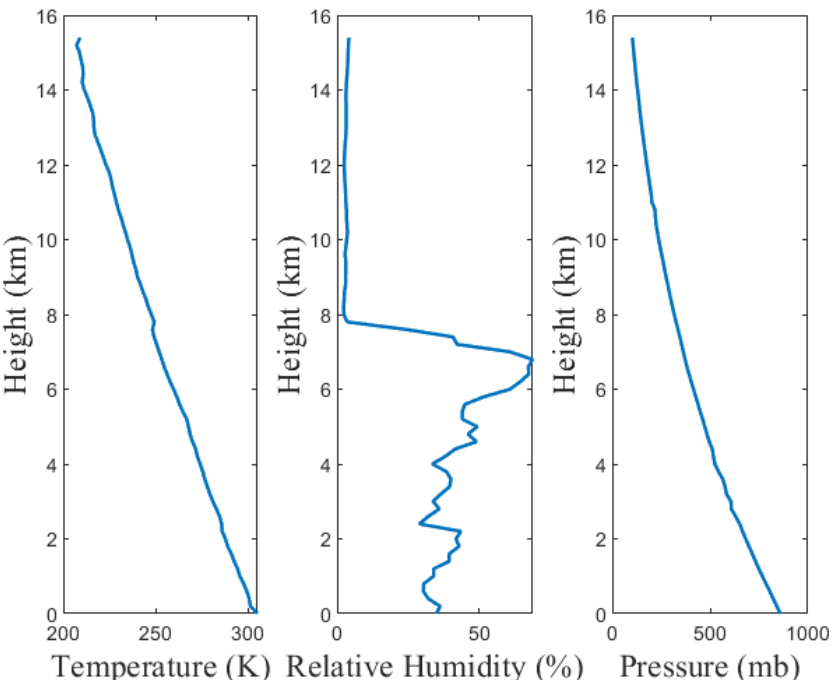
Figure 10. Atmospheric profile data from sounding balloons, including temperature, relative humidity, and atmospheric pressure.